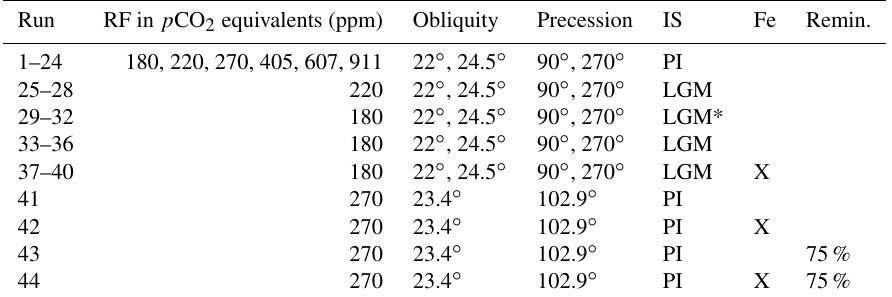
Table 1. Simulation overview. A total of 44 simulations were analyzed with varying radiative forcing (RF), obliquity, precession, ice sheets (PI, pre-industrial; LGM, Last Glacial Maximum reconstruction; LGM*, topography of LGM ice sheets but with PI albedo), and with and without iron fertilization. Runs 1–40 are described by Galbraith and de Lavergne (2018). Runs 43 and 44 and identical to 41 and 42 but the remineralization rate of sinking organic matter is reduced by 25%. Run RF in p CO 2 equivalents (ppm) Obliquity Precession IS Fe Remin.